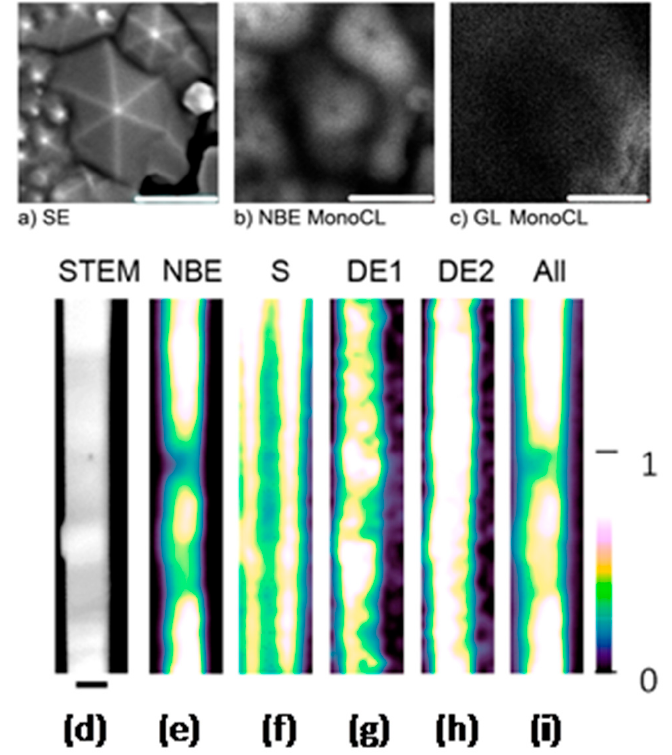
Figure 9. ( a ) Secondary electron micrograph of the ZnO thin film, ( b ) CL monochromatic map taken under ZnO NBE emission, ( c ) Green emission CL monochromatic map at ZnO; all the scale bars are 500 nm long [70]. ( d ) STEM image of nanowire amplitude maps of ( e ) near-band-edge emission, ( f ) surface emission, ( g ) defect emission 1, and ( h ) defect emission 2 deconvolved components. ( i ) Counts integrated across all energies; for further permissions related to the material (d–i), please refer to ACS https://pubs.acs.org/doi/10.1021/acs.jpclett.8b03286 [76] .